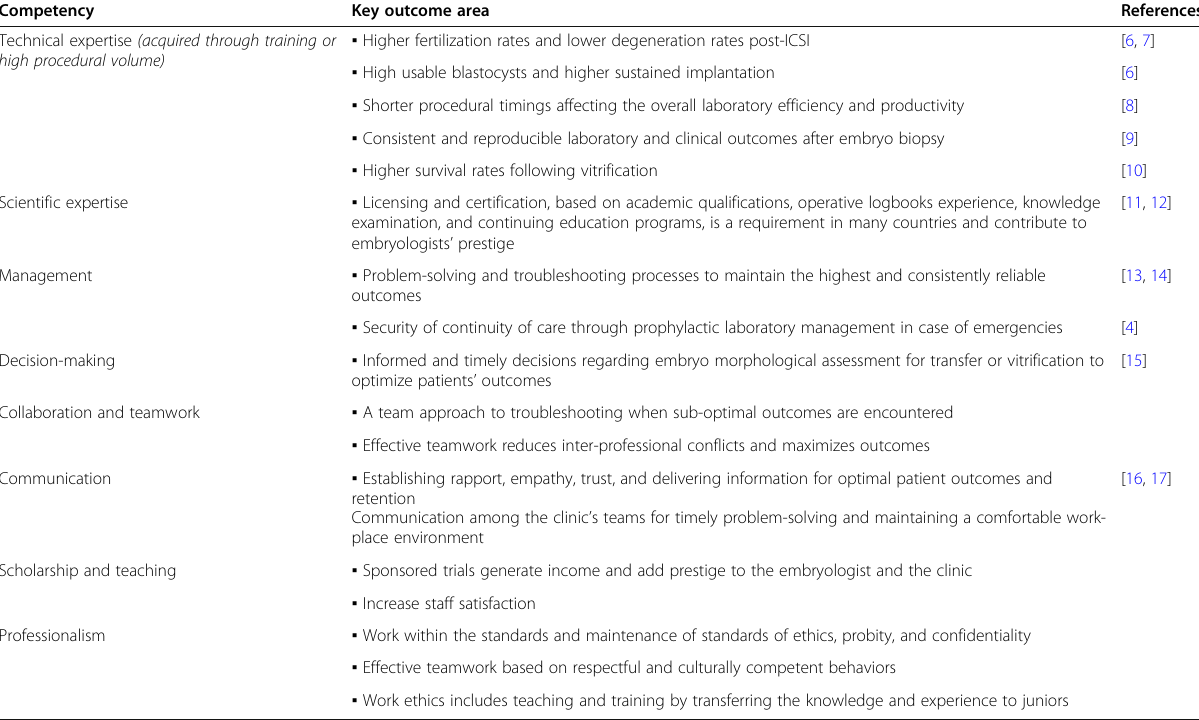
Table 1 The core competencies of embryologists associated with key outcome